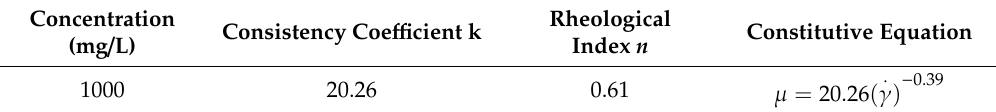
Table 4. Constitutive equation of polymer solution.